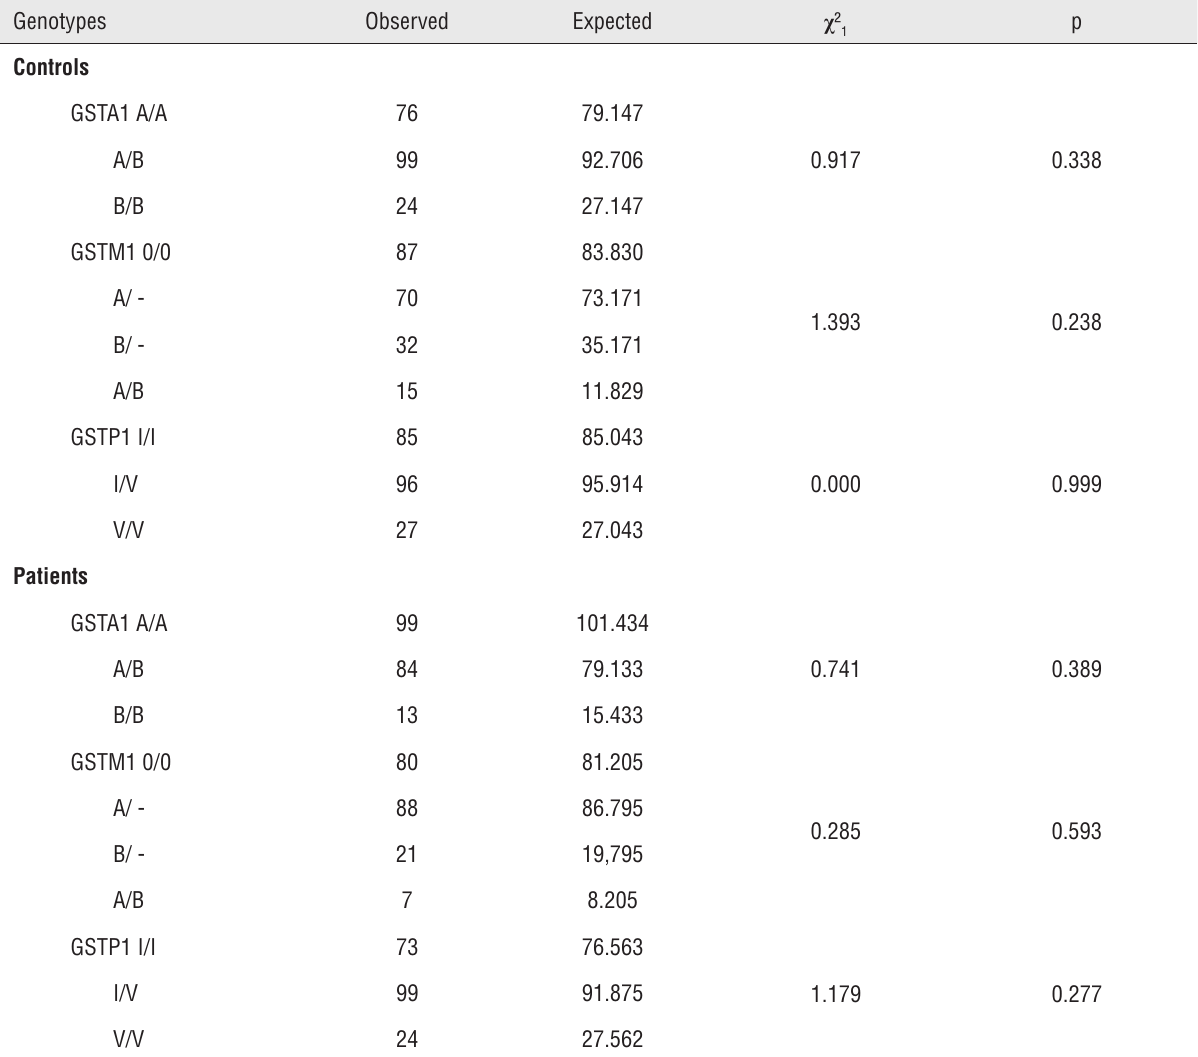
Table 2 - Analysis of Hardy-Weinberg equilibrium for the genetic sample of controls and patients with PCa